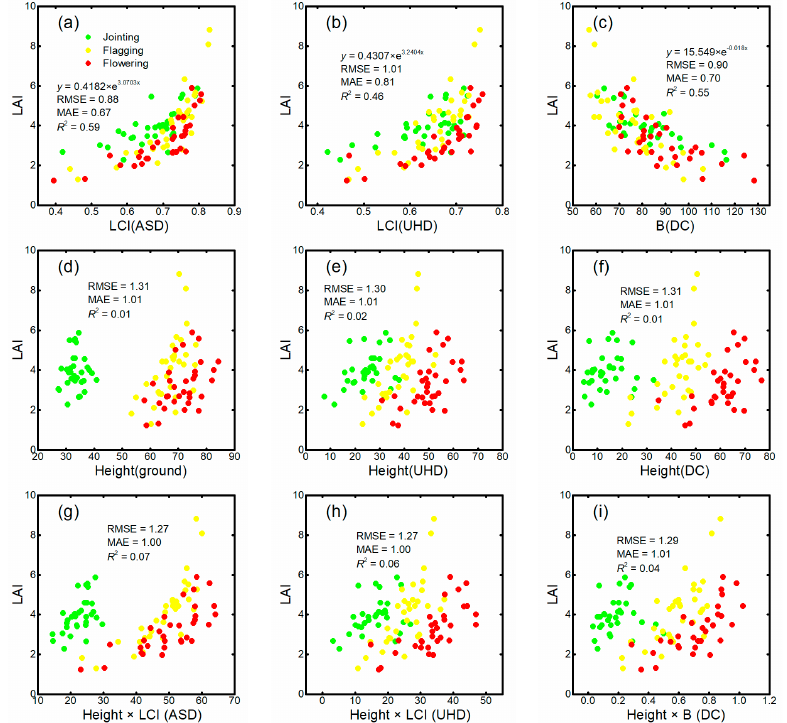
Figure 7. Relationship between best VIs and LAI: ( a ) G-LCI; ( b ) UHD-LCI; ( c ) DC-B; ( d ) G-height; ( e ) UHD-height; ( f ) DC-height; ( g ) G-height × LCI; ( h ) G-height × LCI; ( i ) DC-height × B. 3.2.2. Relationships between (i) Crop Height and (ii) Leaf Area Index and Above-Ground Biomass